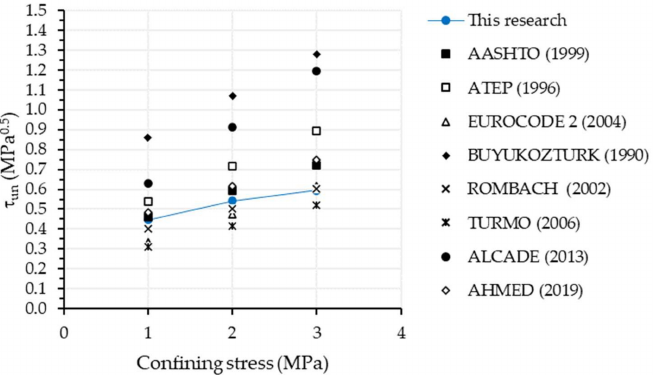
Figure 23. Experimental results and prediction of maximum normalized shear stress of the single- keyed RAC dry joints using the equations in the literature